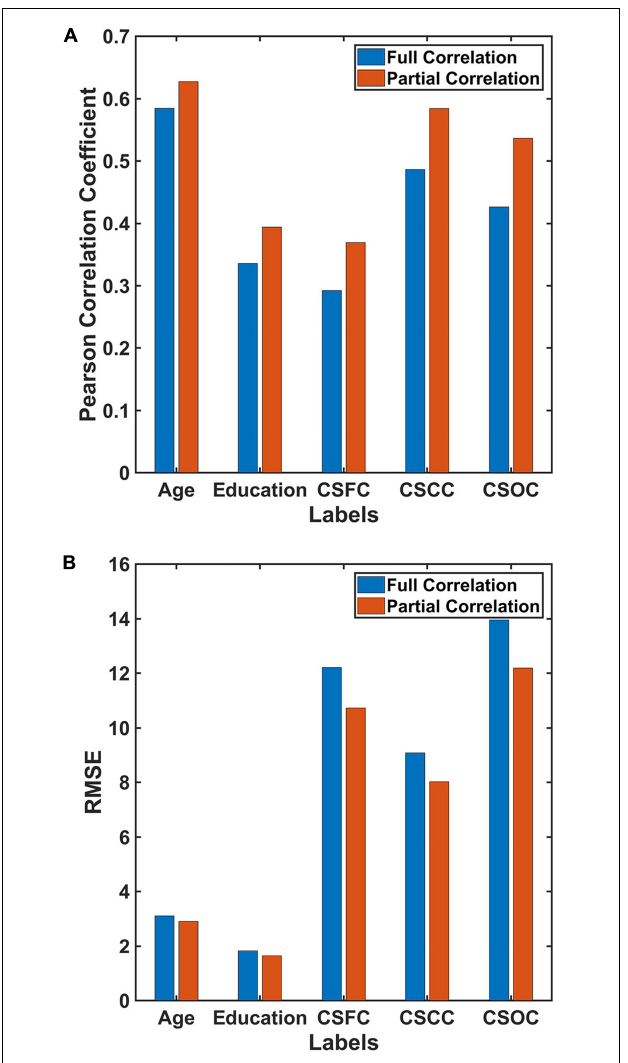
FIGURE 6 | Estimations based on different RSFC evaluation strategies. The reported values were (A) Pearson correlation coefficient and (B) RMSE. The results indicated that estimations based on RSFCs evaluated using partial correlation were better than those based on RSFCs evaluated using full